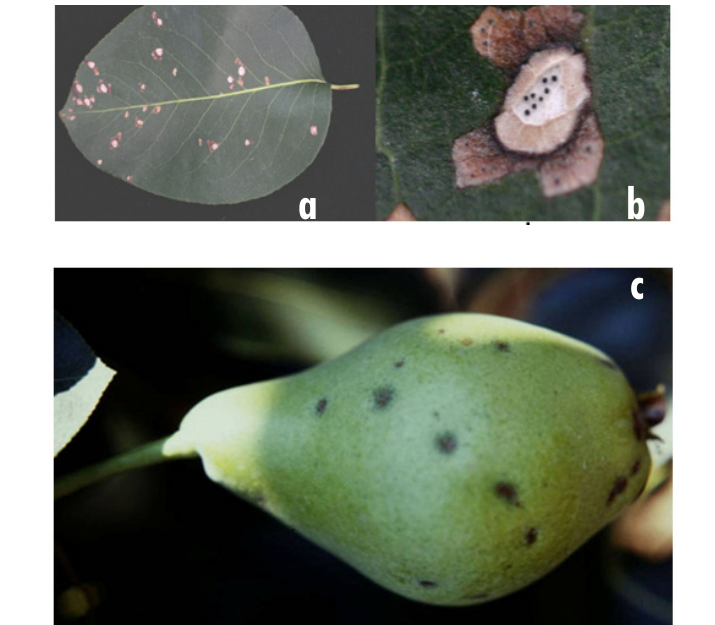
Figure 1. Disease symptoms of Septoria pyricola on pear: a, spots on leaves; b, pycnidia ( × 10) on a leaf spot; c, lesions on